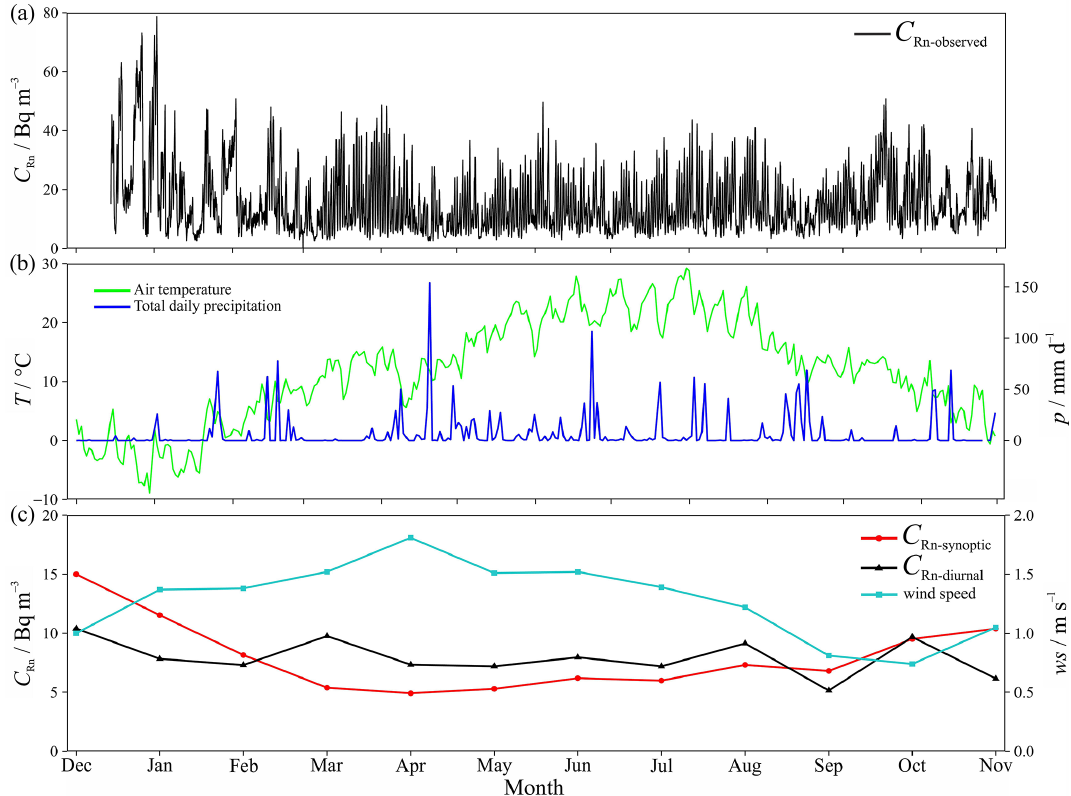
Figure 5. A total of 1 year (December 2016 to November 2017) of (a) hourly mean radon concentration, (b) hourly mean air temperature and total daily precipitation, and (c) monthly mean of synoptic radon, diurnal mixing of radon, and wind speed.